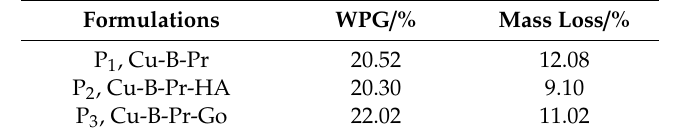
Table 4. Mass loss of control and treated samples.